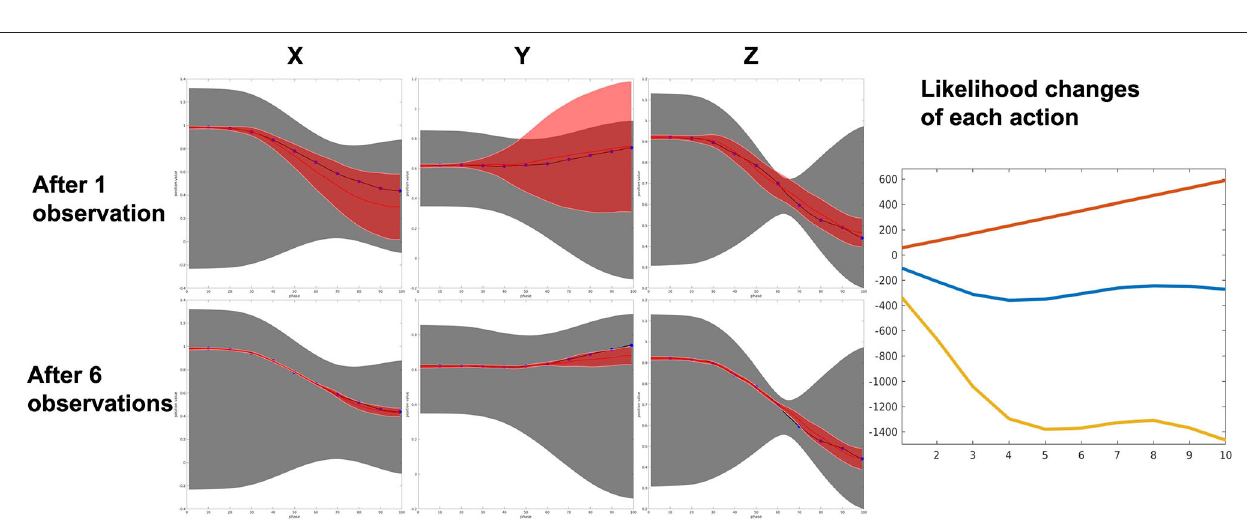
FIGURE 15 | An example of reaching action recognition by 10 observation data. (Top) The proposed framework can recover the correct ProMP model from a mixture model. (Bottom) Reach action is identified and generalized based on observations. Right: Log likelihood of reach (red) is far higher than the other two actions, although overlapping of the prior make cause certain